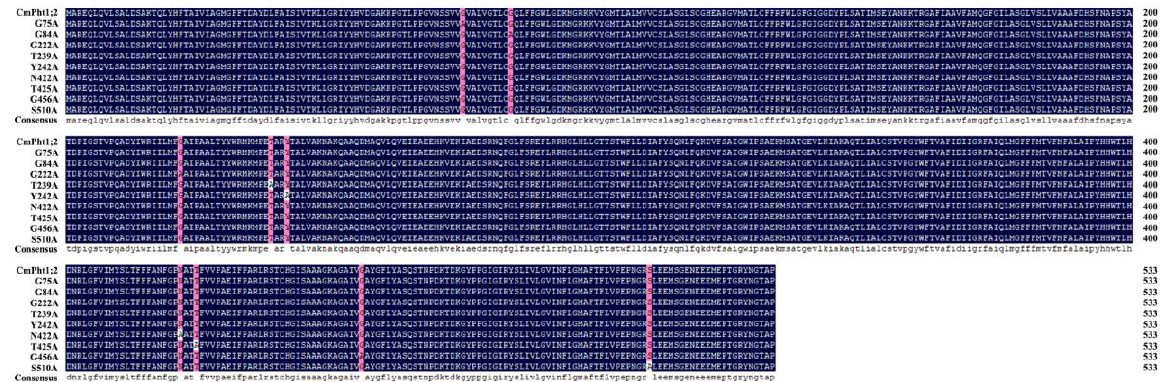
Figure 1. Sequences of 9 PTM mutation sites in CmPT2 phosphate transporter.